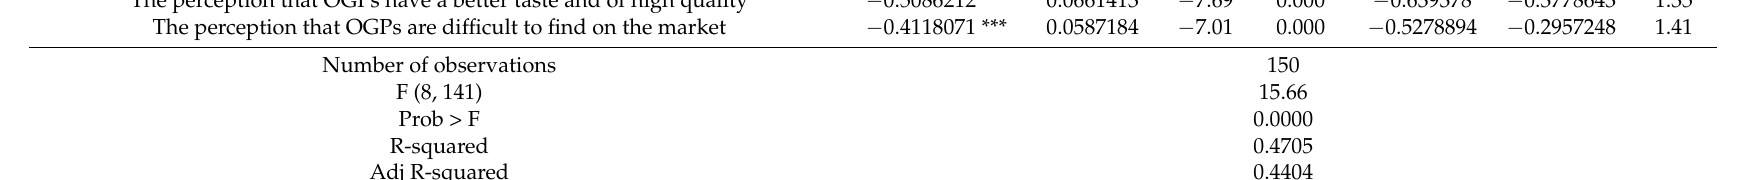
Table 11. Results of the multiple regression model analysis on factors influencing the purchase intentions of organically grown products in Shelly Centre. Parameter Coef. Std. Err. t p > |t| [95% Conf. Interval] VIF The ethnicity of consumer_Not of African descendant (Coloured, White or